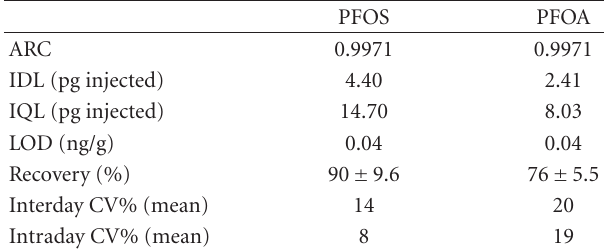
Table 2: Method linearity as average regression coe ffi cient (ARC), instrumental detection limit (IDL), instrumental quantification limit (IQL), limit of detection (LOD) and limit of quantification